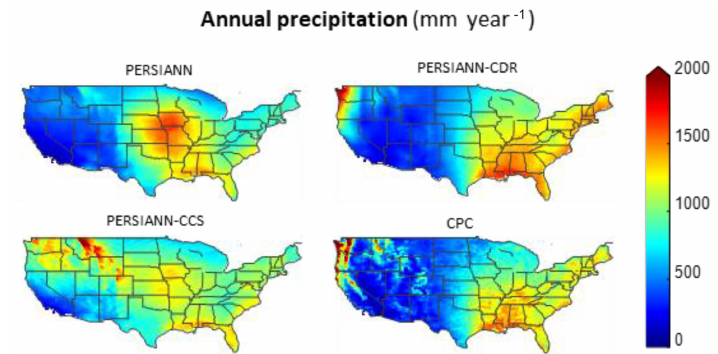
Figure 1. Average annual precipitation (mmyr − 1 ) for the period (2003–2015) over the CONUS.